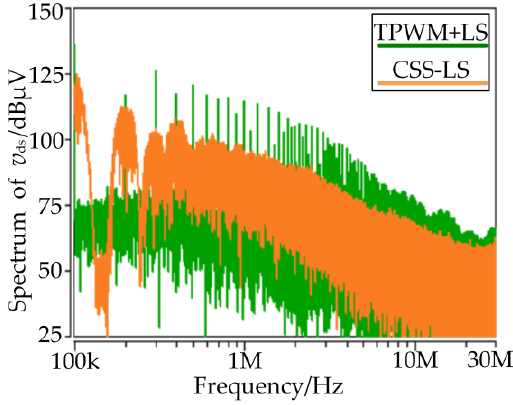
Figure 9. Drain – source voltage spectrum under TPWM and CSS –